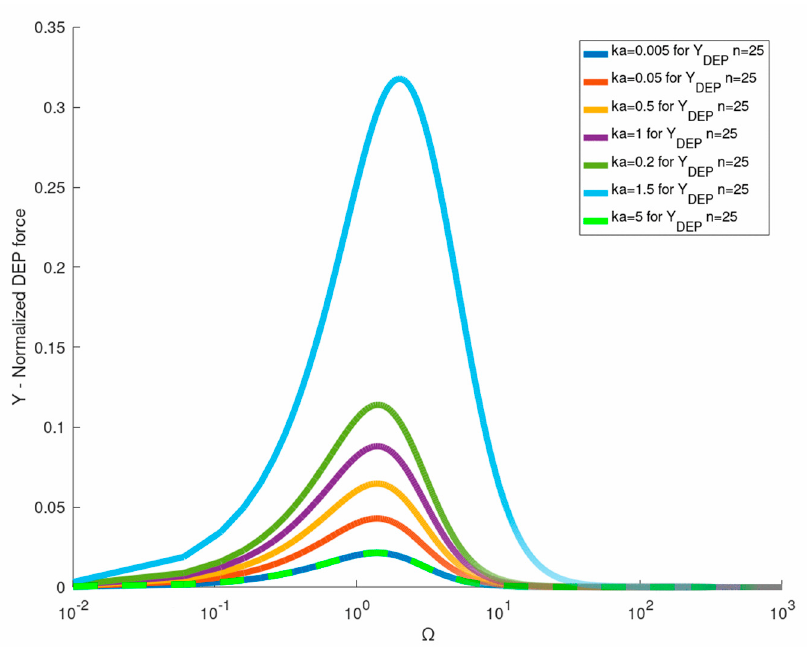
Figure 4. Comparison of the exact expression for the twDEP force (Equation (41)) for different ka values against the ‘long wave’ approximation ( n = 1 ).